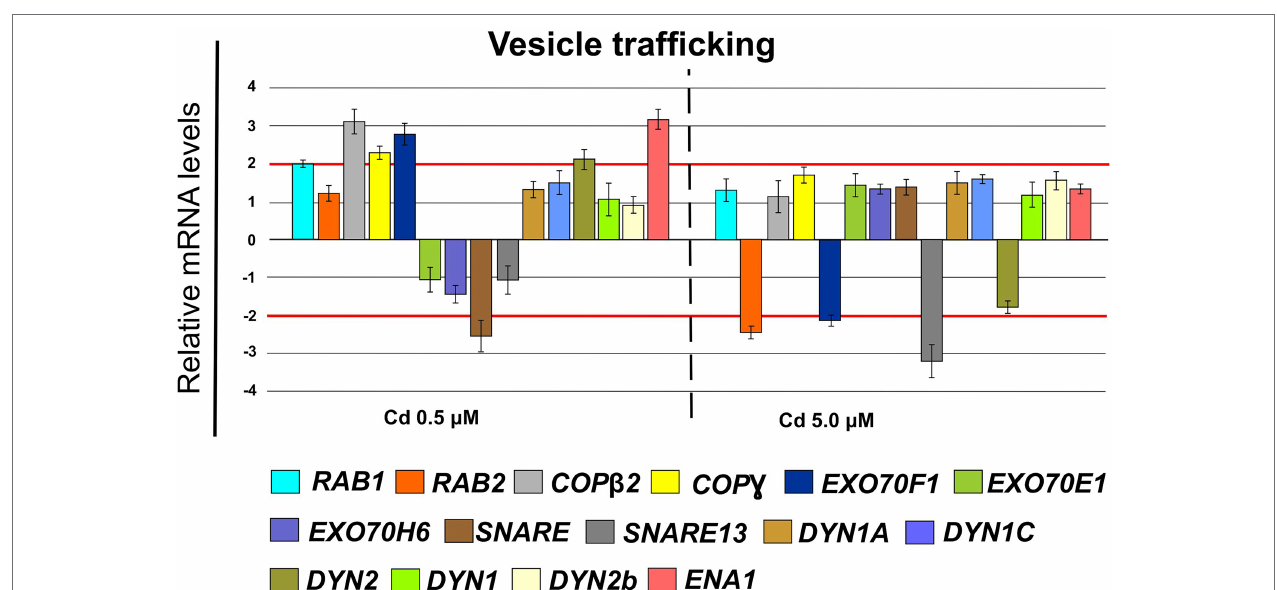
FIGURE 13 | Expression analysis of genes coding for proteins involved in the vesicular trafficking in roots (15 days from sprouting and from the start of Cd treatments). RAB1 ( Ras-related in brain 1 ), RAB2 ( Ras-related in brain 2 ), COPß1 ( coat protein ß1 ), COP ϒ ( coat protein ϒ ), EXO70F1 ( exocyst component of 70 kDa F1 ), EXO70E1 ( exocyst component of 70 kDa E1 ), EXO70H6 ( exocyst component of 70 kDa H6 ), SNARE ( soluble N-ethylmaleimide-sensitive factor attachment receptor ), SNARE13 ( soluble N-ethylmaleimide– sensitive factor attachment receptor 13 ), DYN1A ( dynamin 1A ), DYN1C ( dynamin 1C ), DYN2 ( dynamin 2 ), DYN1 ( dynamin 1 ), DYN2b ( dynamin 2b ), ENA1 ( nicotianamine exporter 1 ). Red lines highlight the fold changes 2 and − 2 to graphically identify the genes differentially expressed.